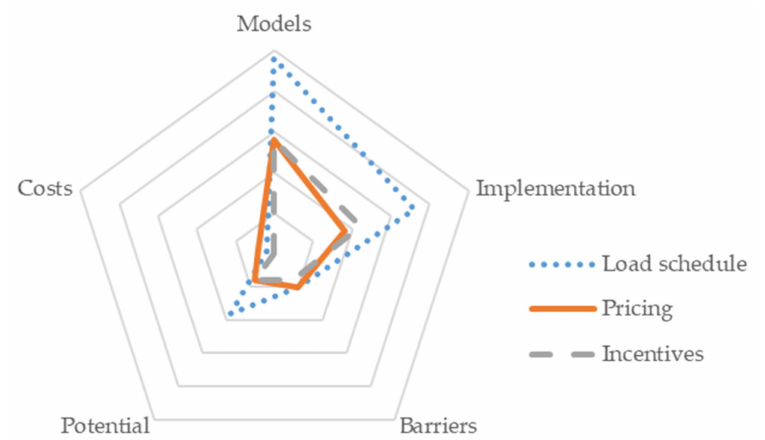
Figure 8. Distribution of the demand response key considerations within the selected